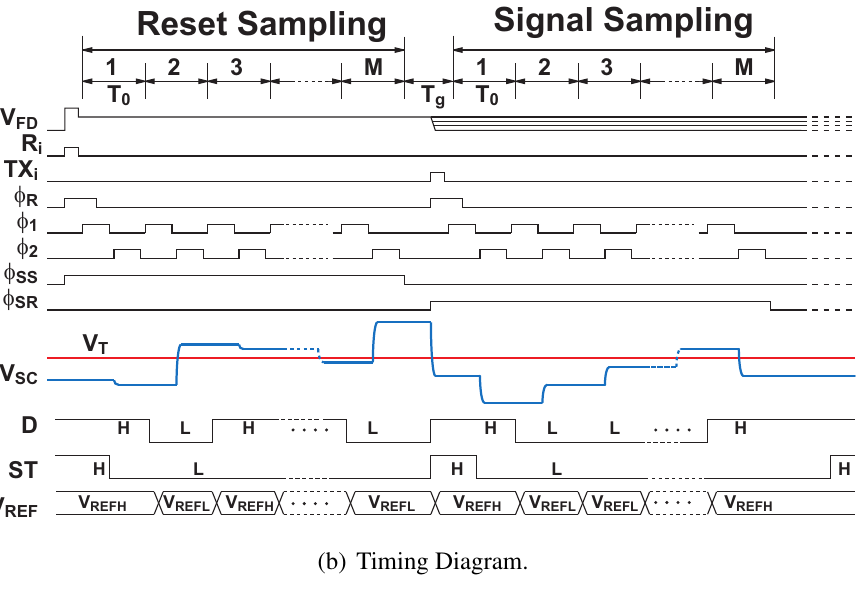
(a) Schematic Diagram of Column-Parallel CMS circuits using the Folding Integration